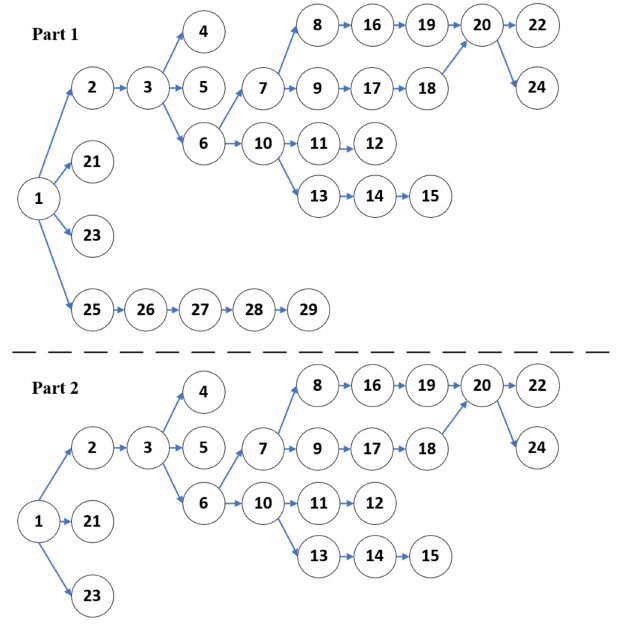
Figure 5. Precedence